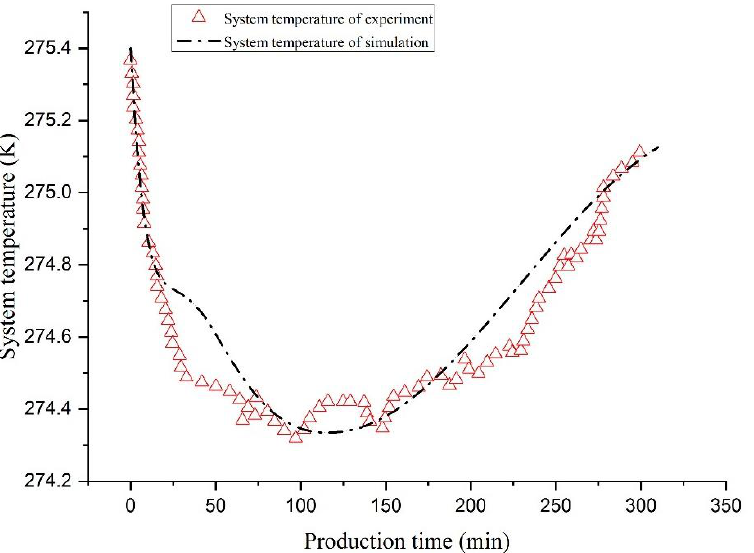
Figure 3. Temperature variation with production time compared with Masuda’s experiment.